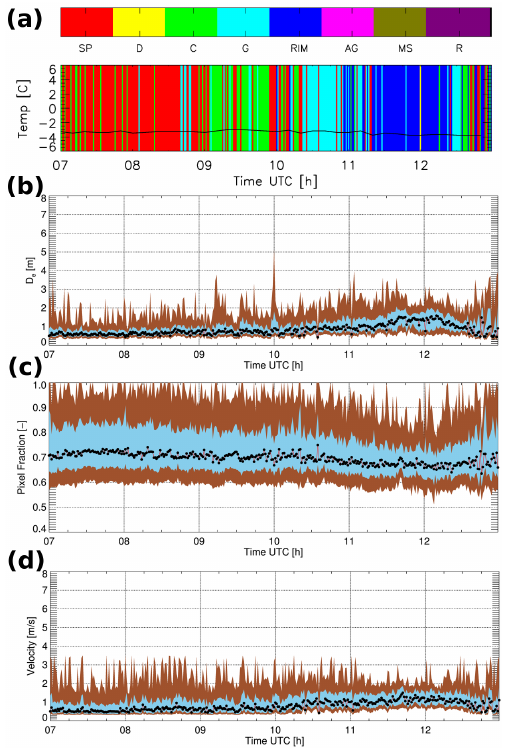
Figure 9. Snowfall event recorded on 17 March 2011. Time series of (a) dominant hydrometeor type as classified with the SVM and local ambient temperature [ ◦ C], as measured by a closely located (distance ≤ 50m) weather station; (b) D e [mm]; (c) pixel fraction of camera A PF A ; and (d) fall velocity v [ms − 1 ]. In panels (b) , (c) , and (d) , black dots connected by the red solid line indicate the median value, while the shaded areas depict Q90–Q10 and Q75– Q25, respectively.